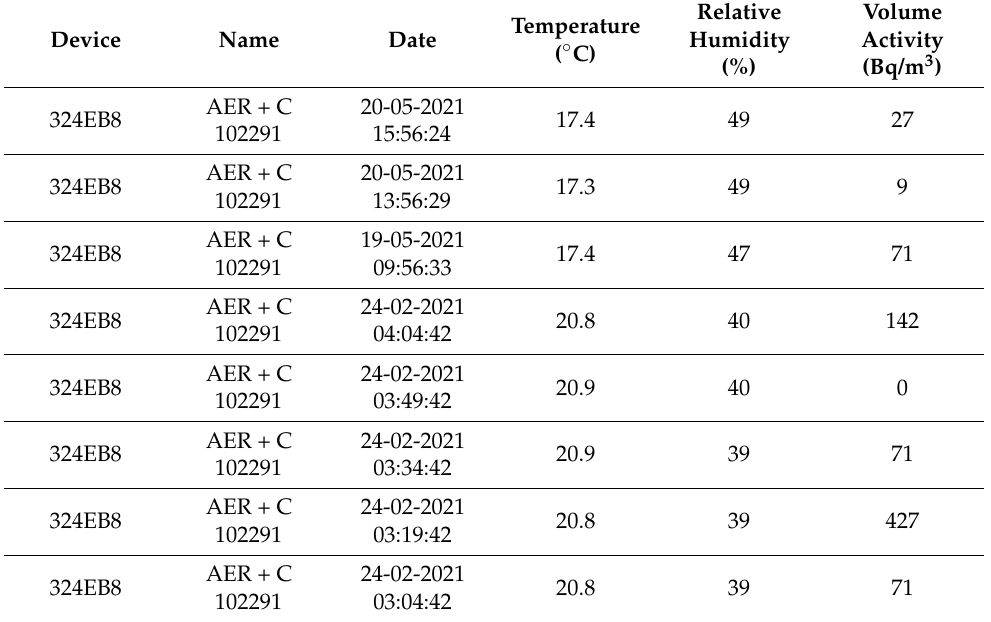
Table 3. Data from AER + C with SigFox